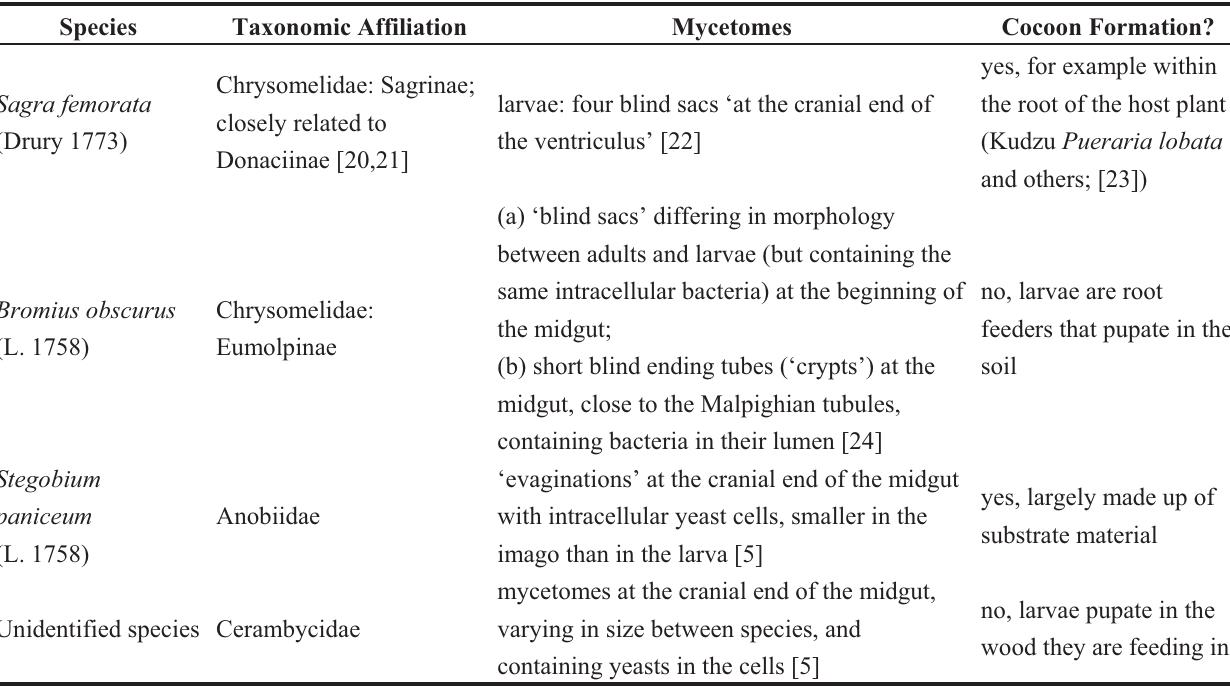
Table 1. Species used in this study and details with respect to the criteria used for the